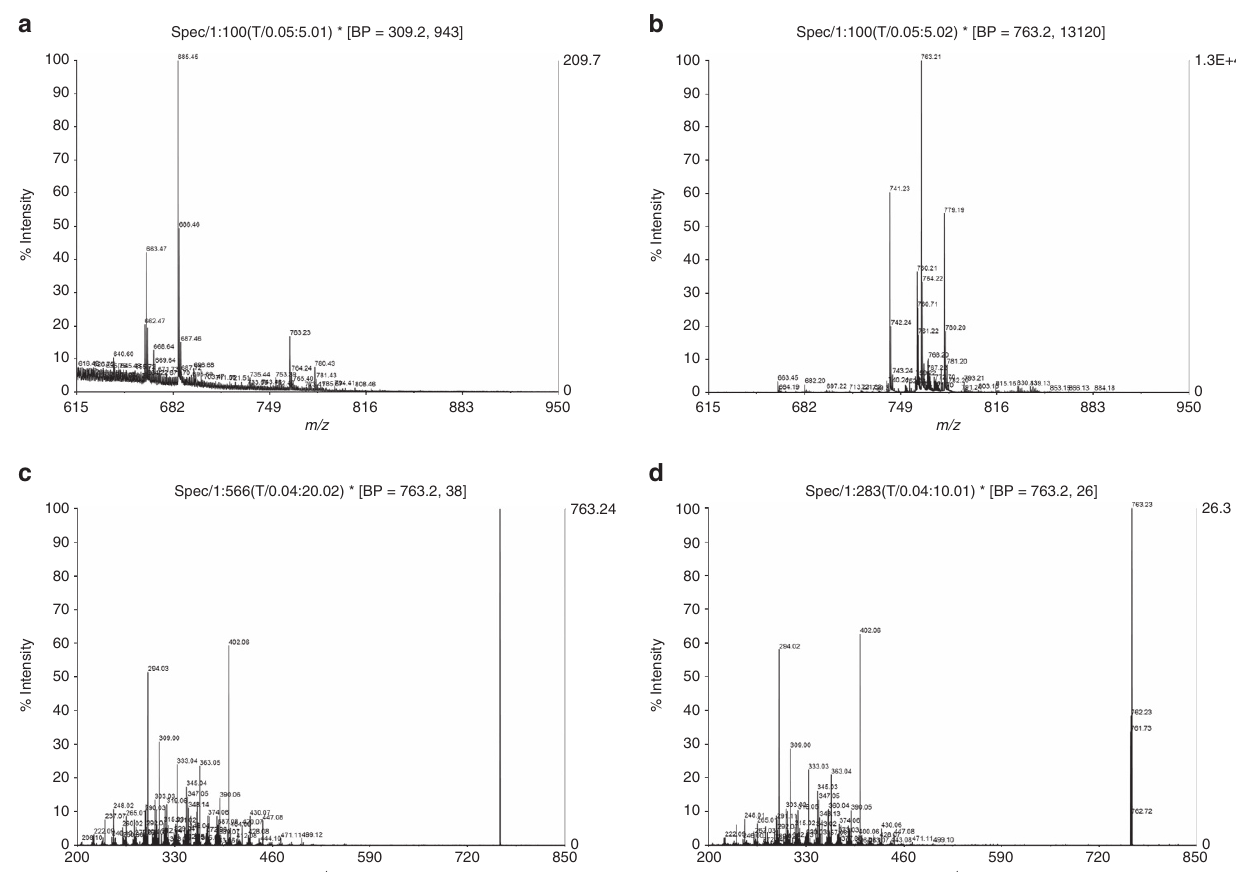
Figure 4 | A tumour-suppressive fraction separated from the culture supernatant of L. casei ATCC334 contained ferrichrome. The mass spectrometry analyses of the tumour-suppressive fraction ( a ) and ferrichrome ( b ) are shown. An ESI-Q-TOF analysis indicated that all of the spectrums of the m/z ratio of the fraction ( c ) corresponded with spectrums of the m/z ratio of ferrichrome ( d